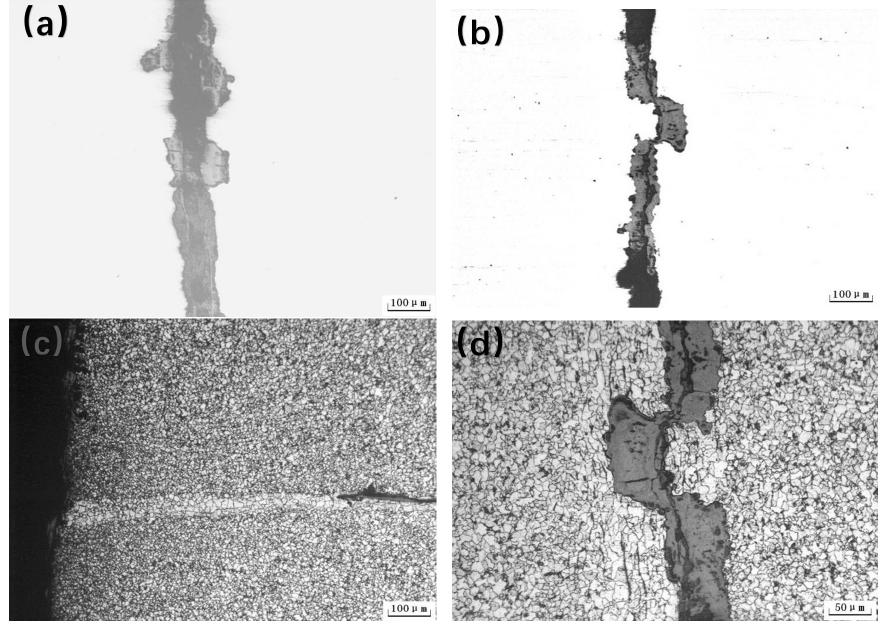
Figure 4. Analysis of weld of 1# cracking pipe: ( a ) C2 sample crack; ( b ) inclusions in crack of C3 sample; ( c ) crack tip morphology and fusion line on inner surface of C3 sample; ( d ) microstructure and oxide inclusions in the middle of the weld fusion line of C3 sample.